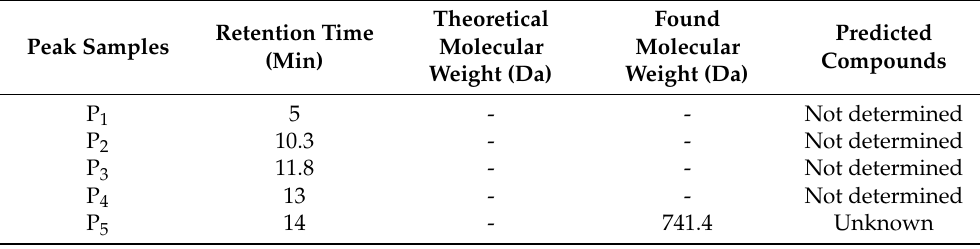
Table 1. Molecular mass of peak samples of EEAS leaves obtained from the preparative RP-HPLC via LC-MS